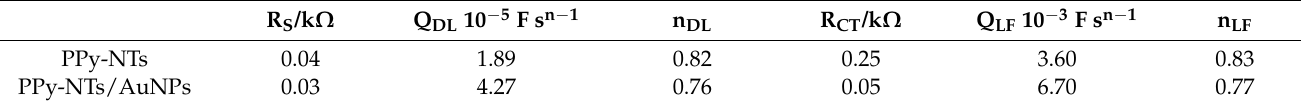
Table 1. Parameters’ values obtained by EIS to PPy e PPy/AuNPs, obtained from fitting of EIS results, R 2 > 0.99. The equivalent circuit was modeled by the NOVA software.